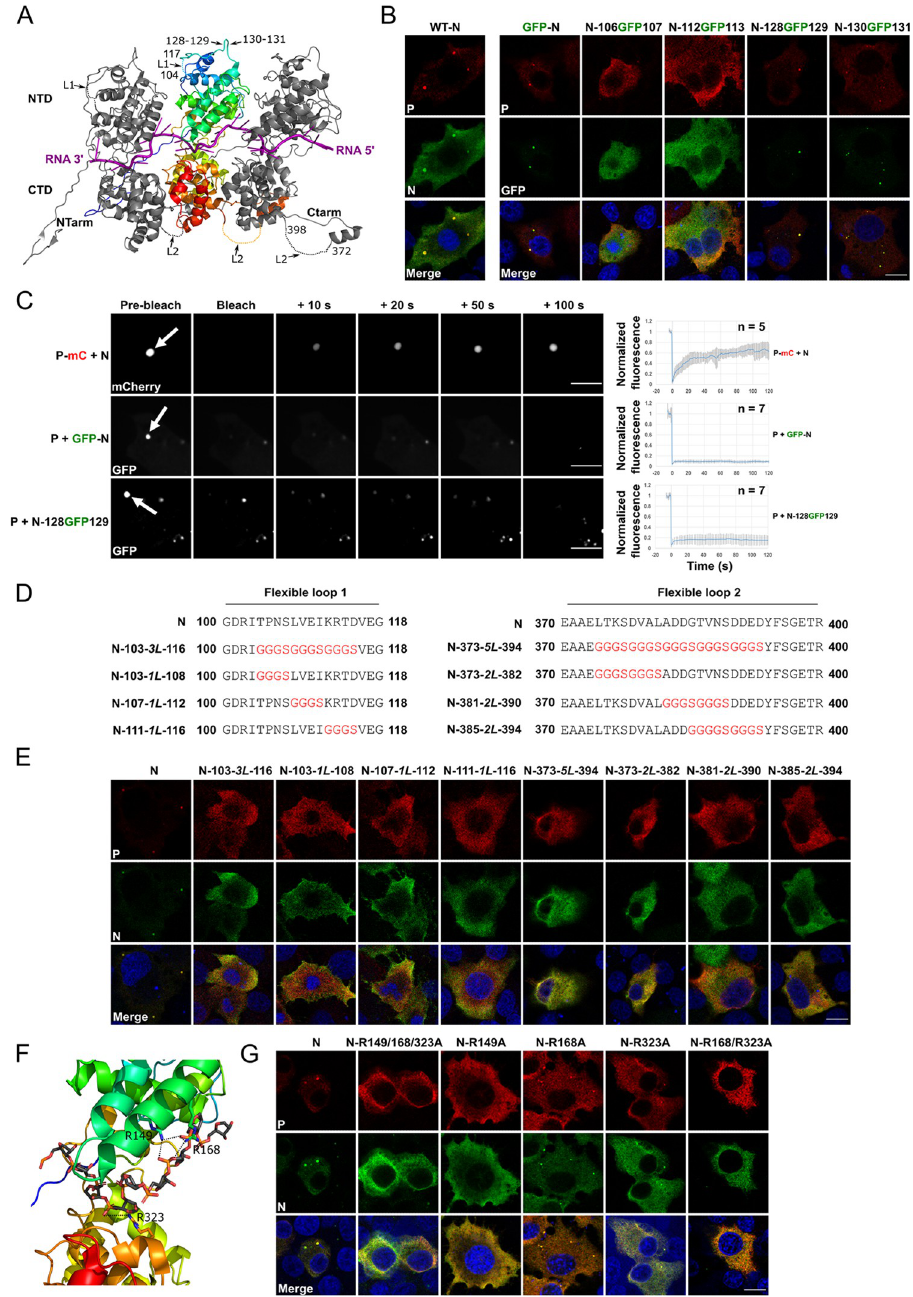
Fig 1. Structural elements of RABV nucleoprotein required for the formation of biomolecular condensates in a cellular minimal system. A) Ribbon representation of the crystal structure of RABV nucleoprotein (PDB 2GTT). Three protomers are shown in complex with RNA (in magenta). The RNA molecule is located in a groove between N amino-terminal domain (NTD) and carboxyterminal domain (CTD). Both domains are extended by two elongated arms (NTarm and CTarm). The central protomer is rainbow colored from N (blue) to C (red) terminus. The loops L1 and L2, absent in the crystal structure, are represented by dotted lines and their position indicated by arrows. The insertion sites between residues 128–129 and 130–131 are also indicated by arrows. B) BSR-T7/5 cells were co- transfected with pTit plasmids encoding P protein and the indicated fluorescent (GFP-N, N-106GFP107, N- 112GFP113, N-128GFP129 and N-130GFP131) or non fluorescent N constructions. Cells were fixed 24 h post transfection and the formation of N-P inclusions was assessed by fluorescence confocal microscopy. P was revealed with a rabbit polyclonal anti-P antibody followed by incubation with Alexa-568 goat anti-rabbit IgG. Scale bar: 10 μ m.